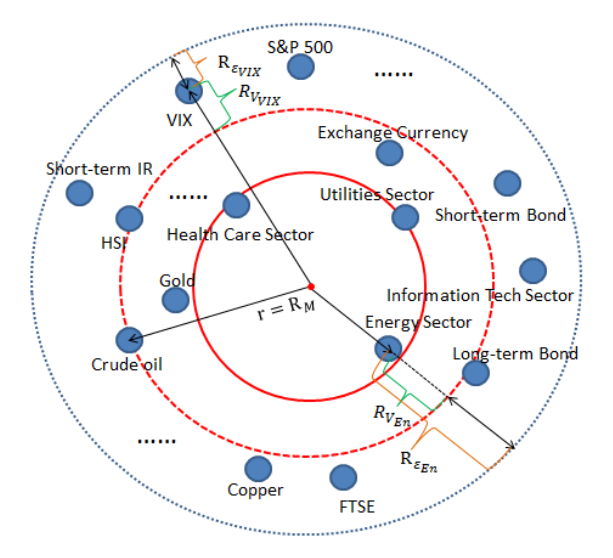
Figure 2. The Change of Financial